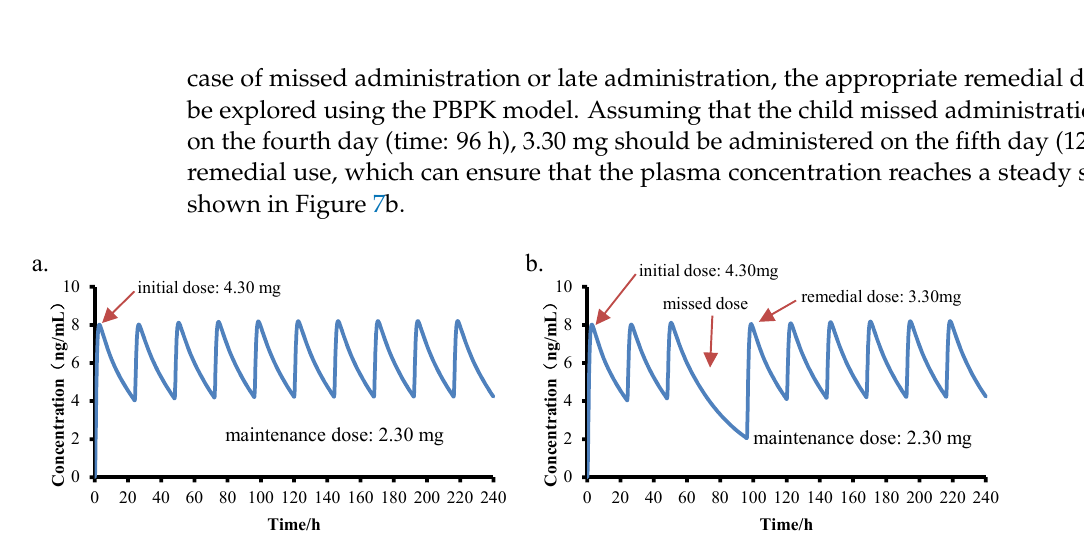
Figure 7. The curve simulation diagram of a personalized administration plan of amlodipine for 6-year-old children. ( a ). Simulated 6: Initial dose: 4.30 mg, maintenance dose: 2.30 mg, q.d.; ( b ). Simulated 7: On the basis of simulation 6, 3.30 mg was taken on the fifth day after missing the fourth day).